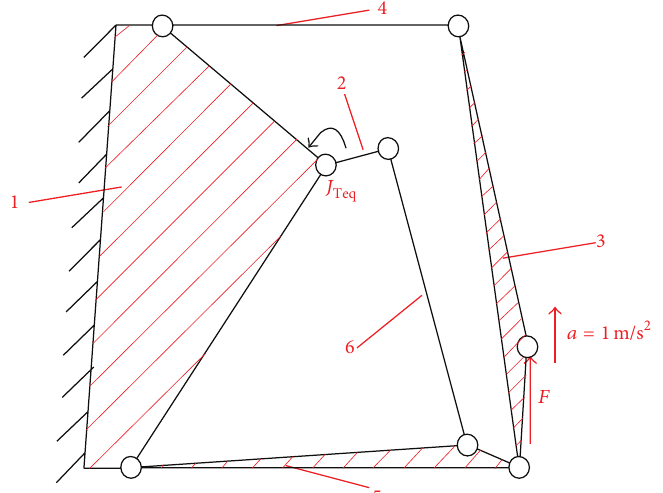
Figure 4: Planar view of suspension structure. (1) Frame; (2) bell crank; (3) knuckle; (4) upper A-arm; (5) lower A-arm; (6) push bar; (7) actuator.